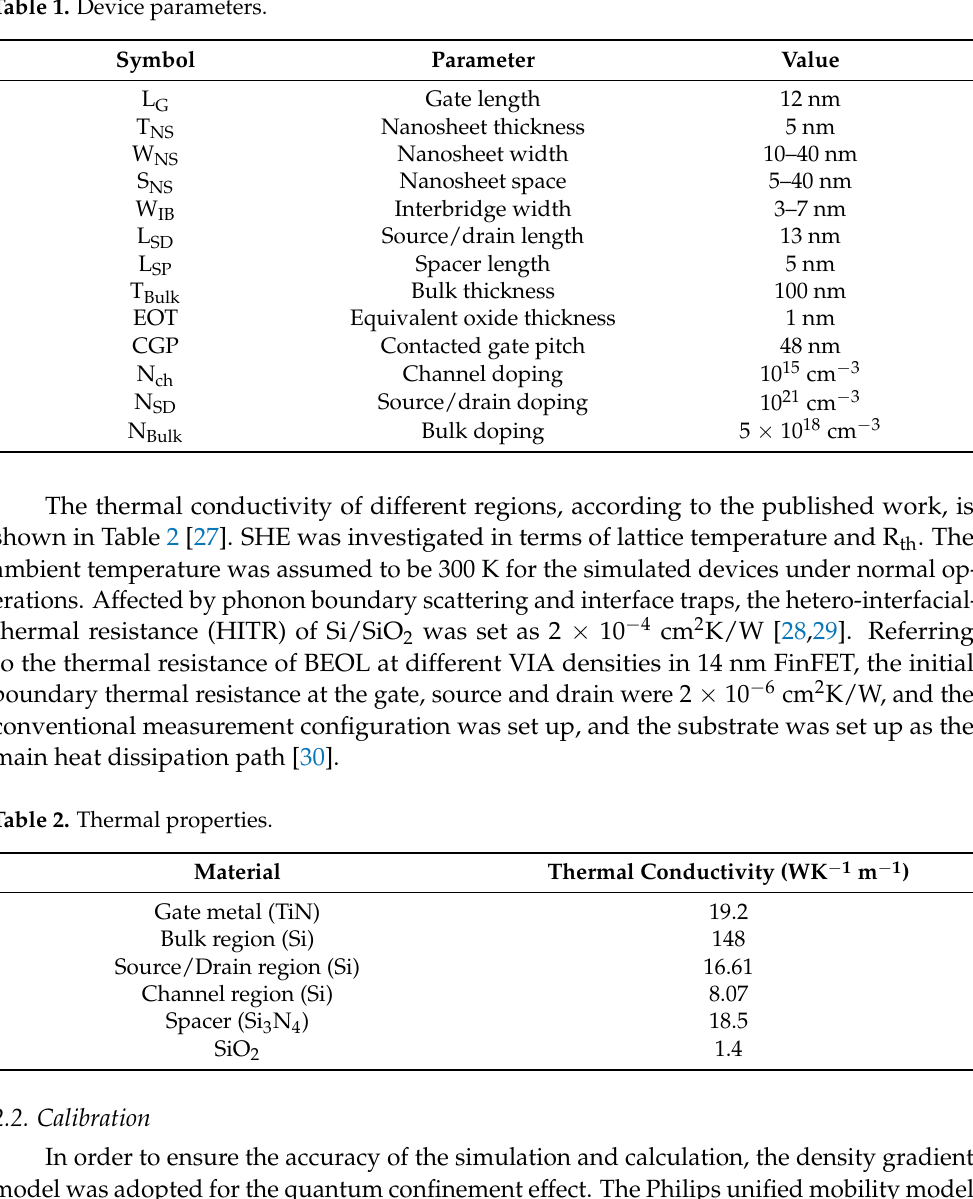
Table 1. Device parameters.